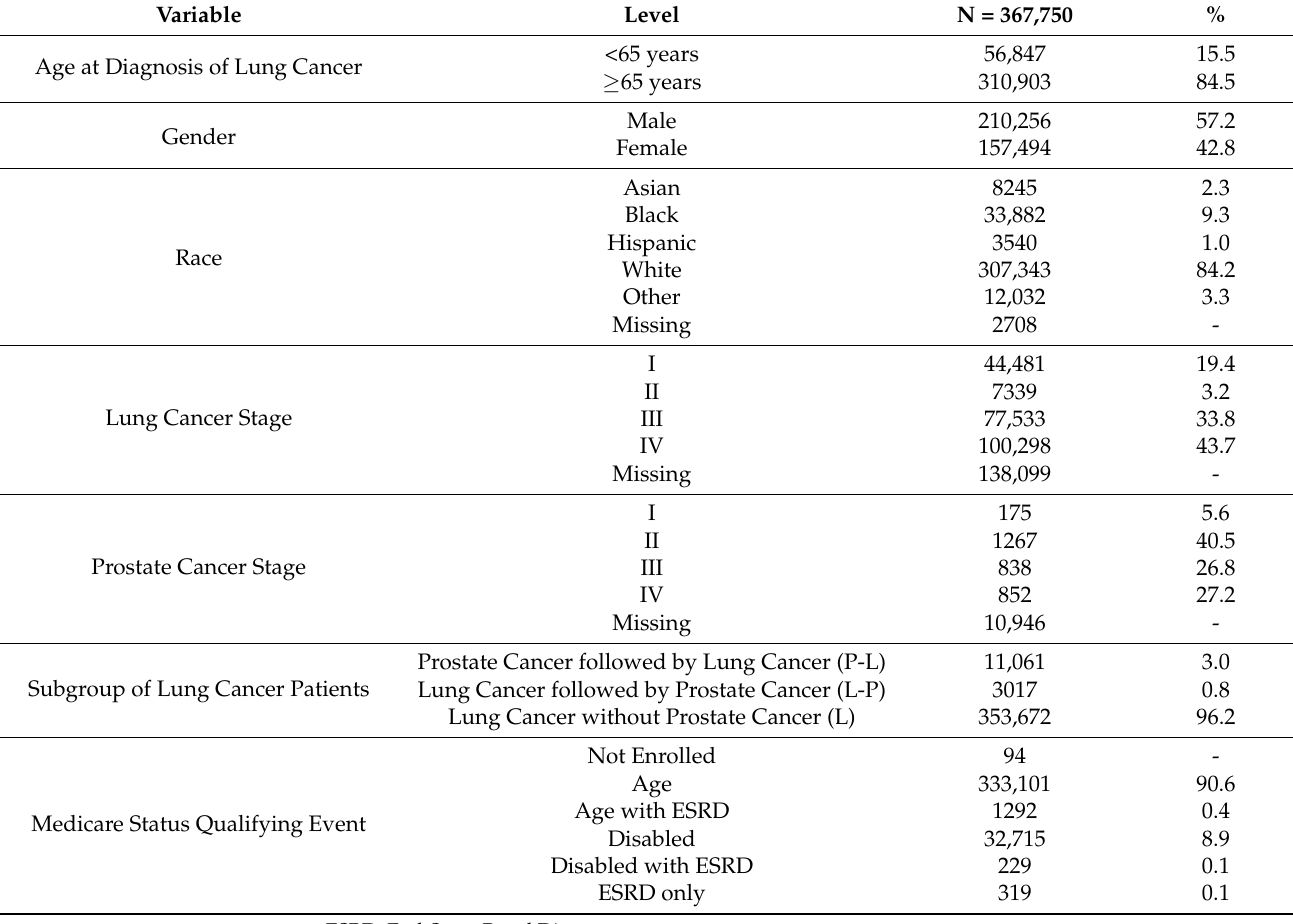
Table 1. Overall summary of patients and tumor characteristics.